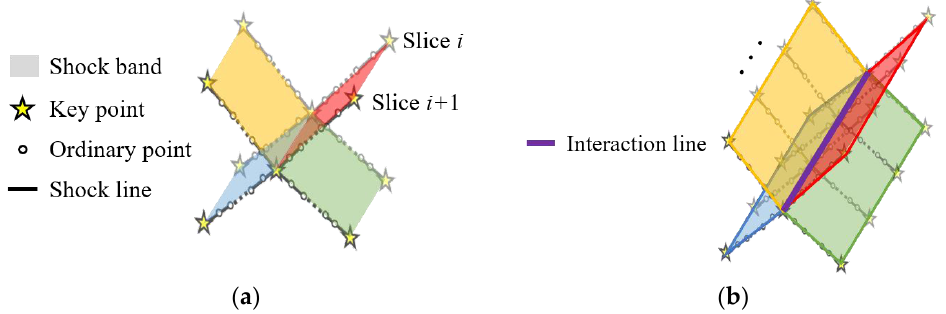
Figure 5. Schematic diagram of the presented three-dimensional shock topology detection method: ( a ) shock bands between two adjacent slices and ( b ) shock surfaces obtained by connecting adjacent shock bands.